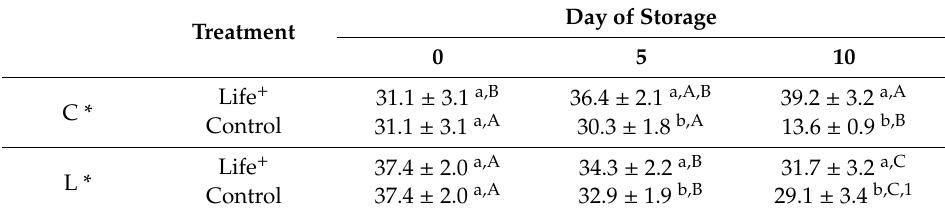
Table 5. Color parameters of strawberries stored at 6 ◦ C for 10 days.